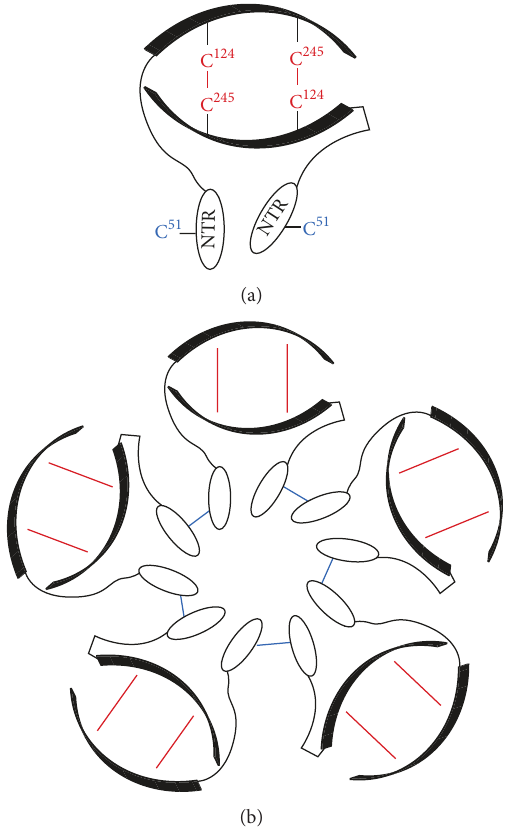
Figure 2: Oligomeric structure of PrxIV. (a) Upon peroxide- mediated oxidation, antiparallel PrxIV dimers are transiently linked by disulfide bonds between C P (C 124 ) on one subunit and C R (C 245 ) on the other subunit (depicted in red), which is the characteristic feature of typical 2-Cys Prxs. However, dimer formation relies on hydrophobic interactions and is redox state-independent. The flexible N-terminal region (NTR) of PrxIV is oriented towards the center of the toroid-shaped, decameric complex (b). The role of the disulfide bonds linking adjacent dimers via Cys 51 in the NTR (depicted in blue) is currently